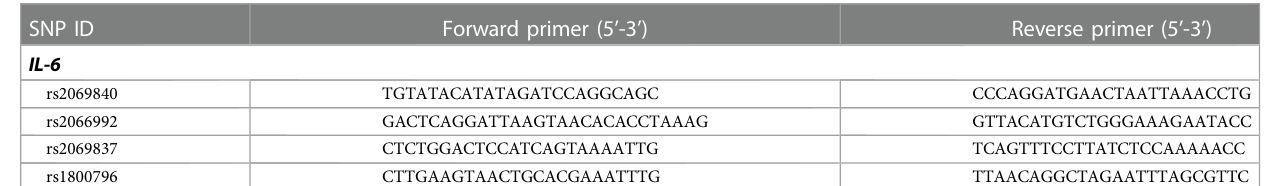
TABLE 2 Primers for multi-PCR.